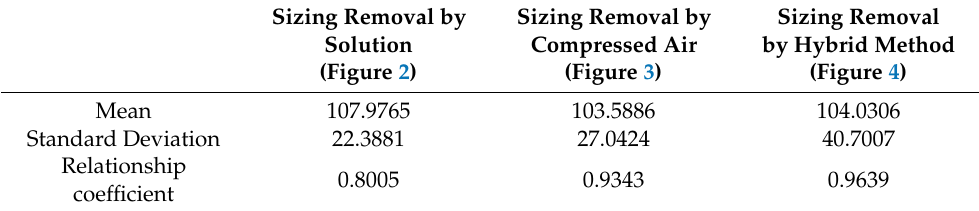
Table 1. Sizing delete state of carbon fiber.